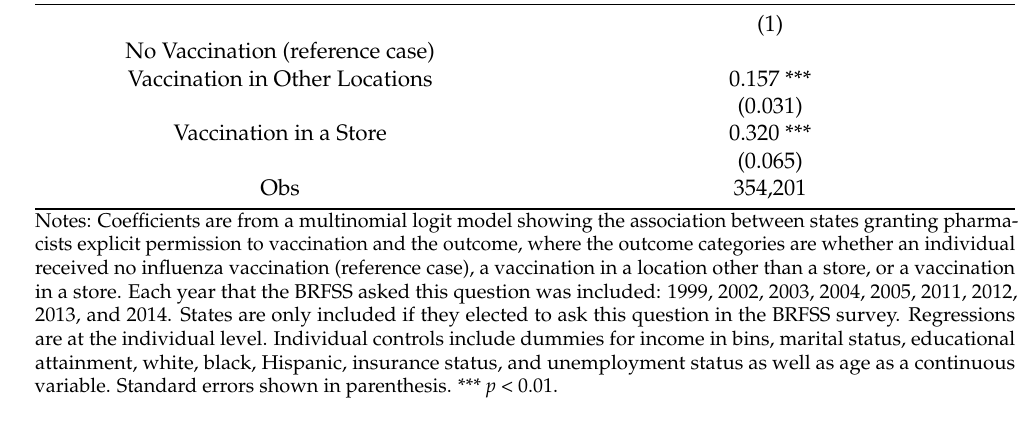
Table A3. Elapsed time between explicit authorization and other regulations on pharmacists’ immu- nization